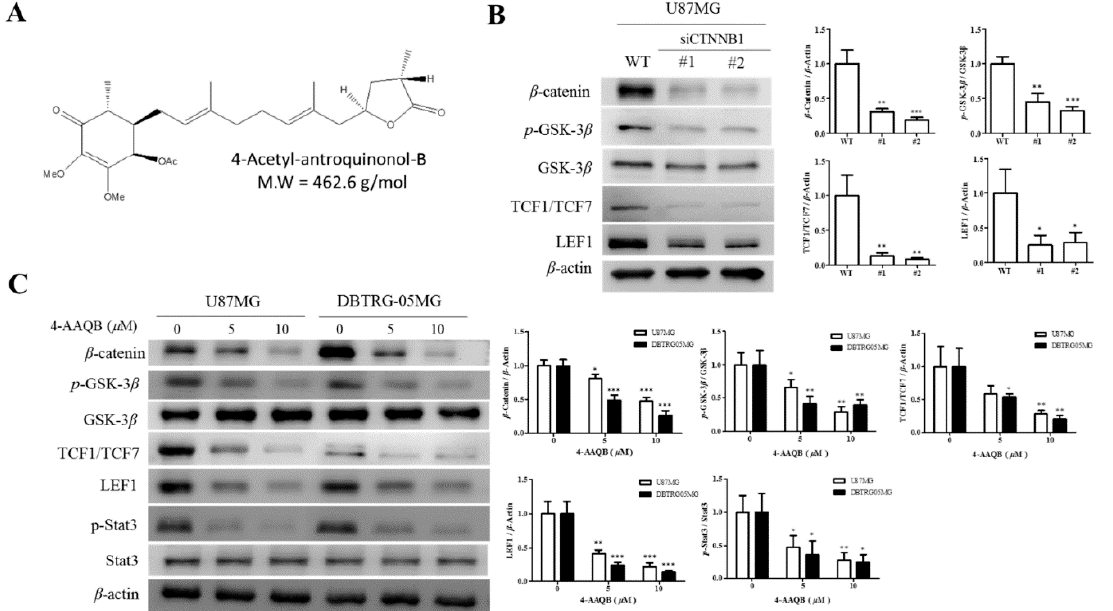
Figure 3. 4-AAQB disrupts β -catenin/TCF-1/Stat3 signaling axis in GBM cells. ( A ) Chemical structure of 4-Acetylantroquinonol B; C26H38O7, 462.58 g/mol. Representative Western blot data and graphical quantification showing ( B ) the knock-down efficiency of β -catenin in human GBM cell line U87MG, with corresponding effect on the expression levels of pGSK3 β , GSK-3 β , TCF1/TCF7, and LEF1 proteins; and ( C ) the dose-dependent downregulation of β -catenin, pGSK3 β , TCF1/TCF7, LEF1, and p-Stat3 proteins in U87MG and DBTRG05MG cells treated with increasing concentrations of 4-AAQB for 24 h. β -actin served as loading control. siCTNNB1, short interfering RNA directed specifically against β -catenin; WT, wild type; * p <0.05, ** p <0.01, *** p <0.001. All data is representative of experiments performed 4 times in triplicates.